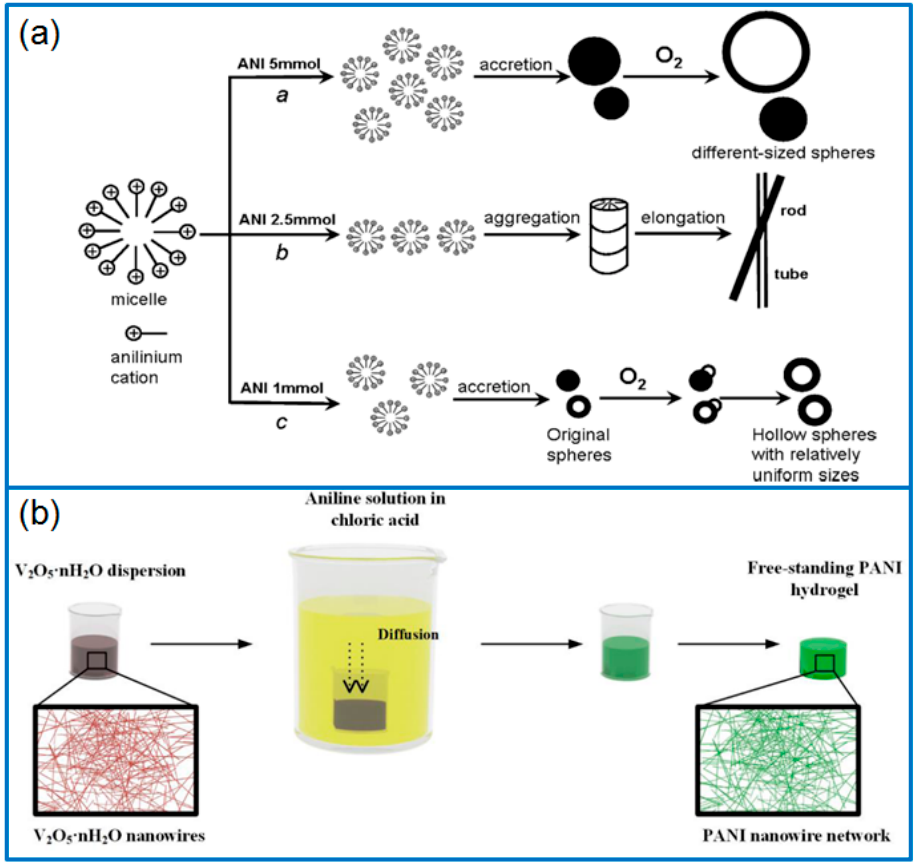
Figure 1. ( a ) Schematic for synthesizing PANI Particles with different morphologies; produced with